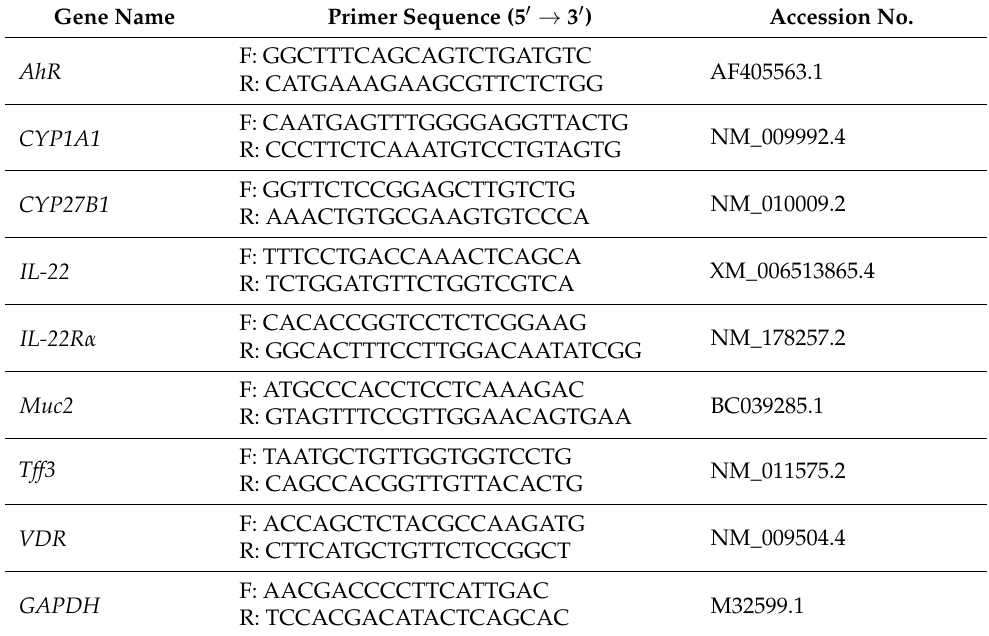
Table 2. Sequences of oligonucleotide primers used for PCR